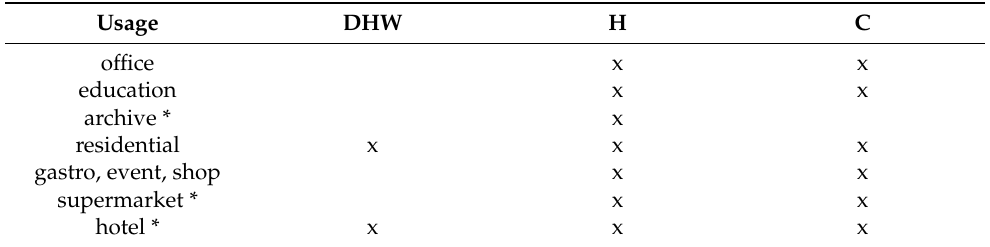
Table 1. Classification of usage and whether energy is needed for H, C and DHW. Categories marked with ∗ are not part of the presented MIDI